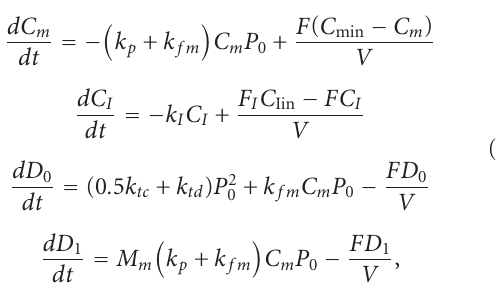
Figure 5: Block diagram of the SISO closed-loop